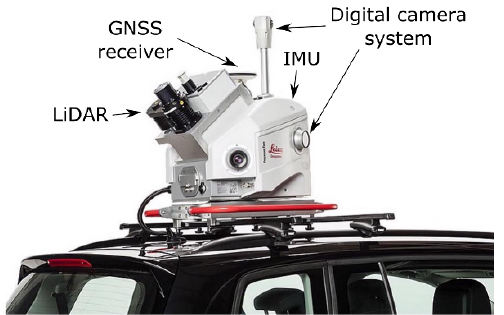
Figure 1. An example of an MMS: a vehicle-mounted mobile mapping platform consisting of different positioning and data collection sensors to generate an accurate georeferenced 3D map of the environment. Shown here are the main sensors of the Leica Pegasus: Two Ultimate as an example. Photo courtesy of Leica Geosystems [13].